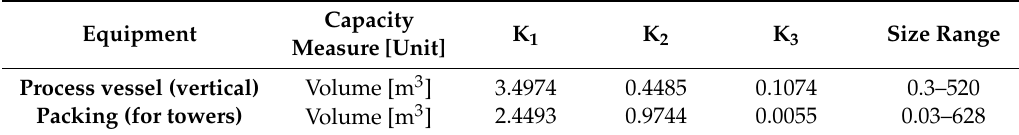
Table A5. Parameters for equipment according to Turton [52].